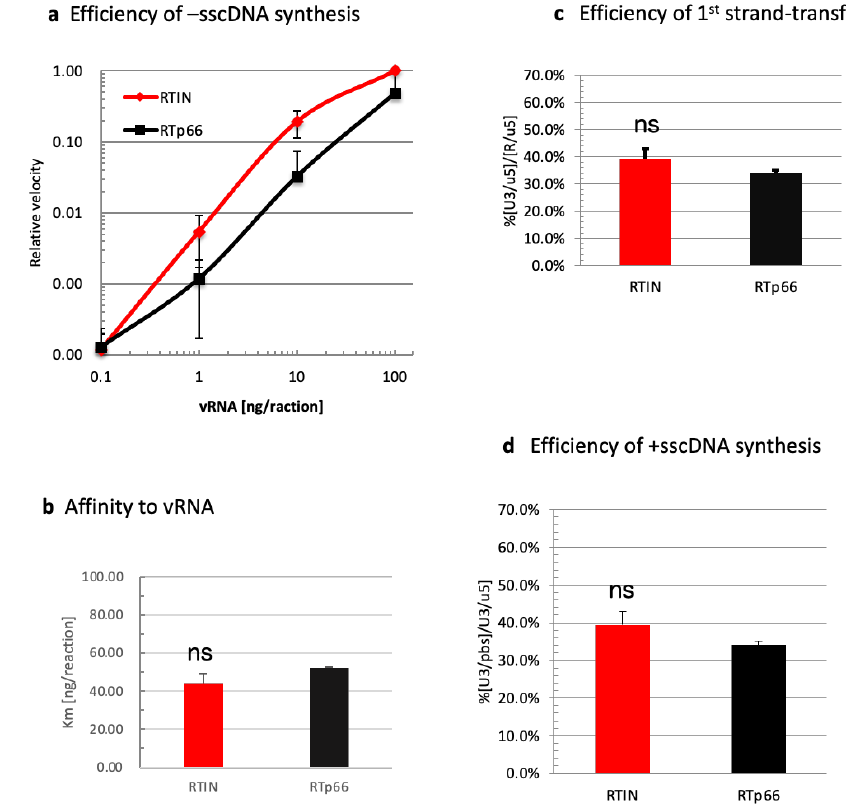
Figure 3. Impact of IN fusion on affinity of RT with vRNA. ( a ) An in vitro reverse transcription assay was performed in the presence of different doses of vRNA (0.1, 1, 10, 100 ng). The R/u5 copy number generated during 60 min incubation was measured and the value at each dose was plotted as a relative velocity to the reaction of rRTIN with 100 ng of vRNA as 1.0. The value at each vRNA dose is shown as means ± SD ( n = 3). ( b ) Km for vRNA was estimated by calculating velocity at vRNA (100 ng/re action) as the maximum velocity in the assay condition. Student’s t analysis showed no significant differences between RTIN and RTp66 (ns, p > 0.05). ( c ) The efficiency of the 1st strand-transfer was determined by calculating the relative (%) amount of the U3/u5 to that of each R/u5 product (% of [U3/u5]/[R/u5]) in the reaction with 100 ng vRNA). d. The efficiency of the +sscDNA synthesis was determined by calculating the relative (%) amount of the U3/pbs to that of each U3/u5 product (% of [U3/pbs]/[U3/u5]) in the reaction with 100 ng vRNA. ( c , d ) Student’s t analysis showed no significant differences (ns) between RTIN and RTp66 ( n = 3, p > 0.05). 3.4. Impact of IN Fusion on Affinity of RT to dNTPs Cellular levels of deoxyribonucleoside triphosphates (dNTPs) are critical determi- nants for retrovirus reverse transcription and infection [5]. We next examined -sscDNA generation under different concentration of dNTPs with a fixed amount of vRNA (100 ng per reaction). The velocity of R/u5 (-sscDNA) synthesis during 60 min of the reaction was measured, and data are shown as values relative to the velocity at 100 μM dNTPs as 1.0. Here, we noticed that rRTIN produced R/u5 products with significantly higher efficiency at low doses of dNTPs (1 or 1 0 μM) compared with rRTp66 (Figure 4a). We also examined a heterodimer form of rRT (p66/p51) in parallel. From the velocity plot results, we esti- mated the Km value of rRTIN or rRTs for dNTPs by calculating a concentration of dNTPs to give a relative velocity of 0.5. It should be noted that the Km value of rRTIN was more than ~6-fold lower than that of rRTp66 or rRTp66/p51, suggesting that rRTIN possesses a significantly higher affinity to dNTPs than rRTs (Figure 4b). To address the crucial role of IN fusion to RT, the effect of proteolytic cleavage of RTIN by HIV-1 protease was addressed. Since HIV-1 protease produced a heterodimeric form of RT composed of p66 and p51subunits, rRT in the heterodimeric form (p66/p51)